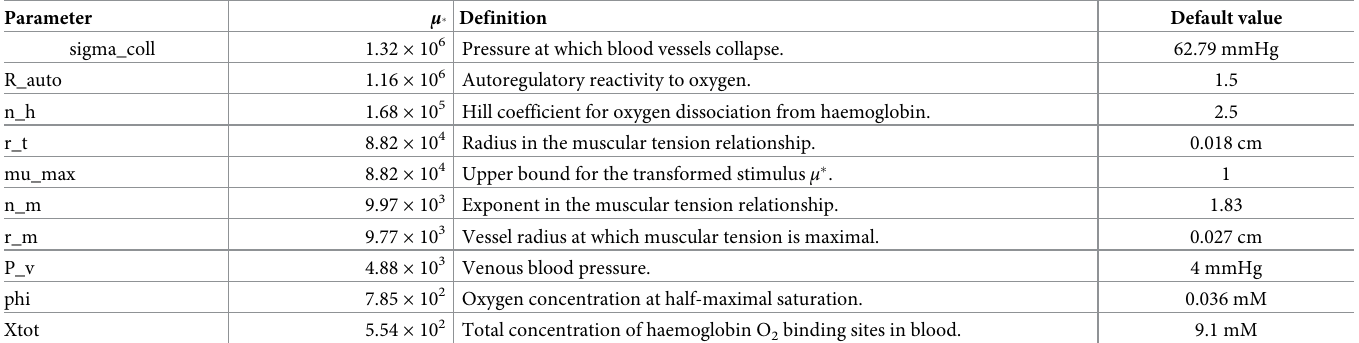
Table 2. Sensitivity analysis results for simulated data, including each selected parameter’s definition and default value. � See [6] and [3] for a full explanation of this parameter and the stimulus μ